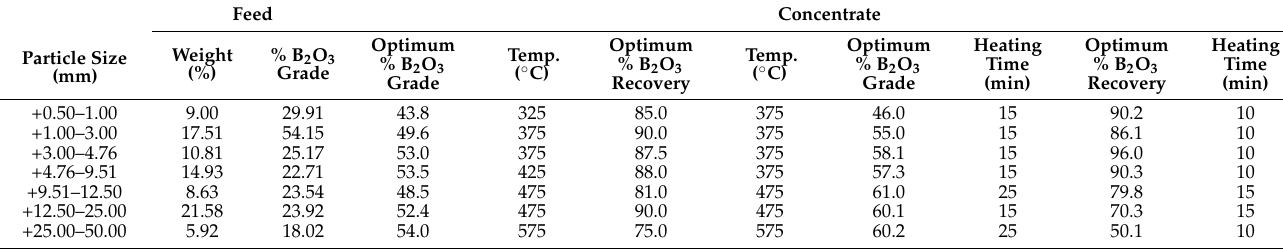
Table 3. Effect of particle size, temperature, and heating time on borax recovery and grade [6]. Feed Concentrate Weight Particle Size (mm)